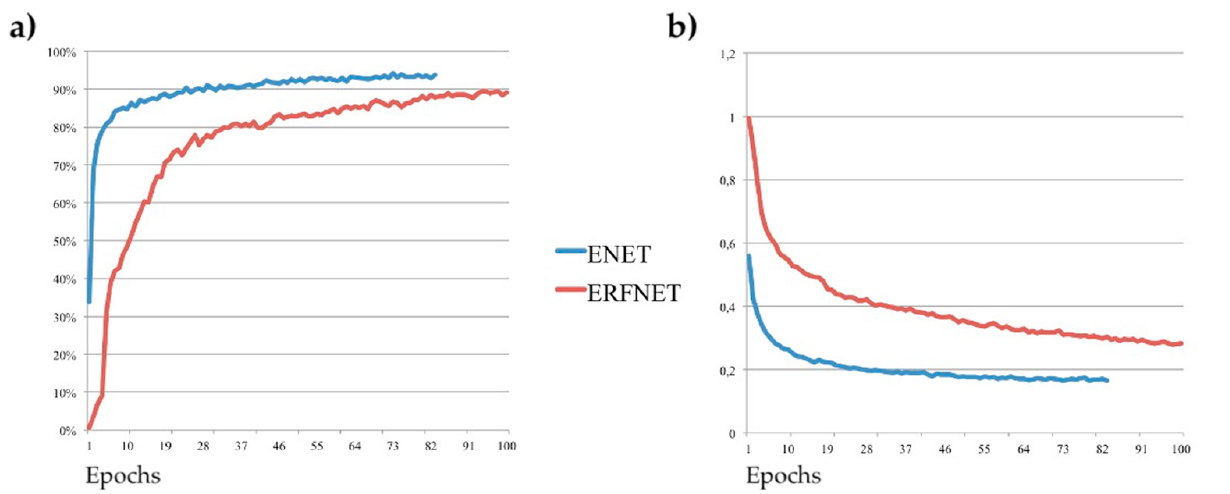
Figure 2. ( a ) Dice similarity coefficient and ( b ) loss function; Tversky loss plots for Efficient Neural Network (ENet) in red lines and Efficient Residual Factorized ConvNet (ERFNet) in blue lines during the training process for one fold. Table 4. Comparison of computational complexity and performance between the two deep learning models.